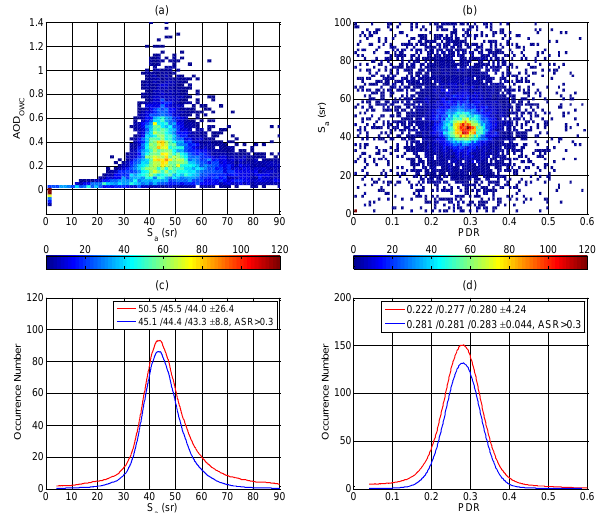
Figure 8. Analysis results for the dust transport region as indicated by the red box in Fig. 6. The upper row shows two-dimensional (2-D) distributions of (a) OWC AOD vs. S a retrieved using OWC AOD as a constraint, (b) S a vs. PDR, while the lower row shows histograms of (c) S a and (d) PDR occurrence frequencies. The S a distribution in (c) has a bin size of 0.1sr and is smoothed, while the bin size for S a in (a) and (b) is 1.5sr. The PDR distribution in (c) has a bin size of 0.001 and is smoothed, while the bin size in (b) is 0.006. The red curves in (c) and (d) include all data and the blue curves are screened data using ASR>0.3. The numbers in the legends of are mean/median/mode ± standard deviation of S a (c) and PDR (d)